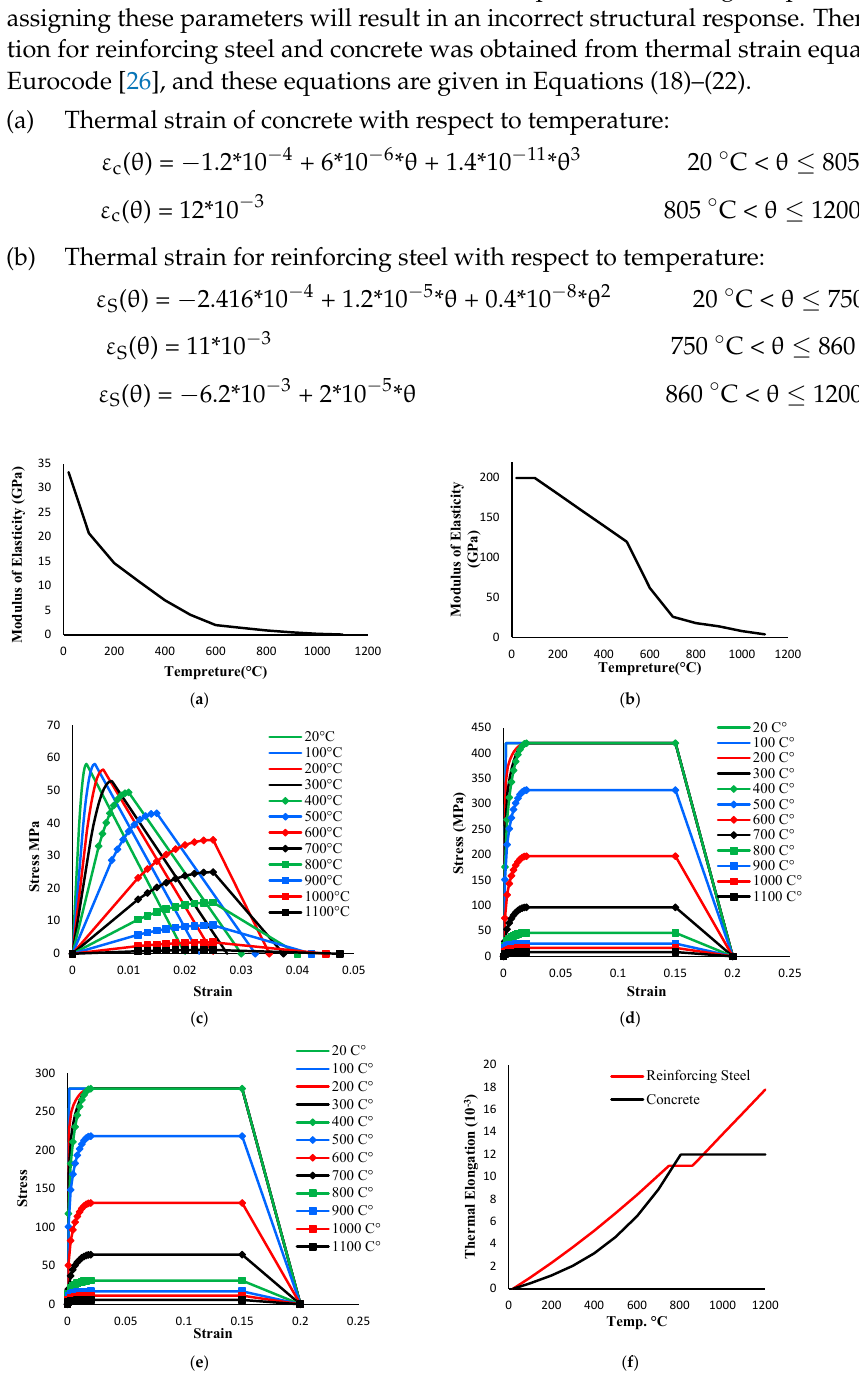
Figure 5. Mechanical properties for elevated temperatures: ( a ) Modulus of elasticity of concrete (N/mm 2 ), ( b ) Modulus of elasticity of steel (N/mm 2 ), ( c ) Stress–strain relationship, ( d ) Longitudinal rebar stress–strain relationship, ( e ) Stirrup stress–strain relationship, and ( f ) Thermal elongation.